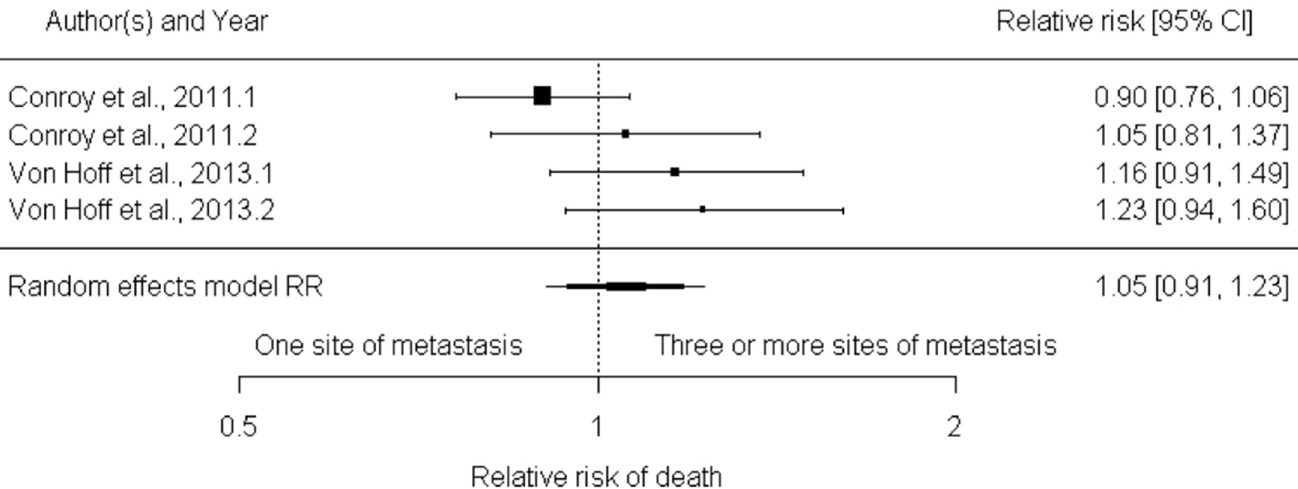
Fig 5. Forest plot for relative risk of death with three or more sites of metastasis compared to one site. The forest plot based on number of events, shows absence of statistical significance of the sites of metastasis in relative risk of death.